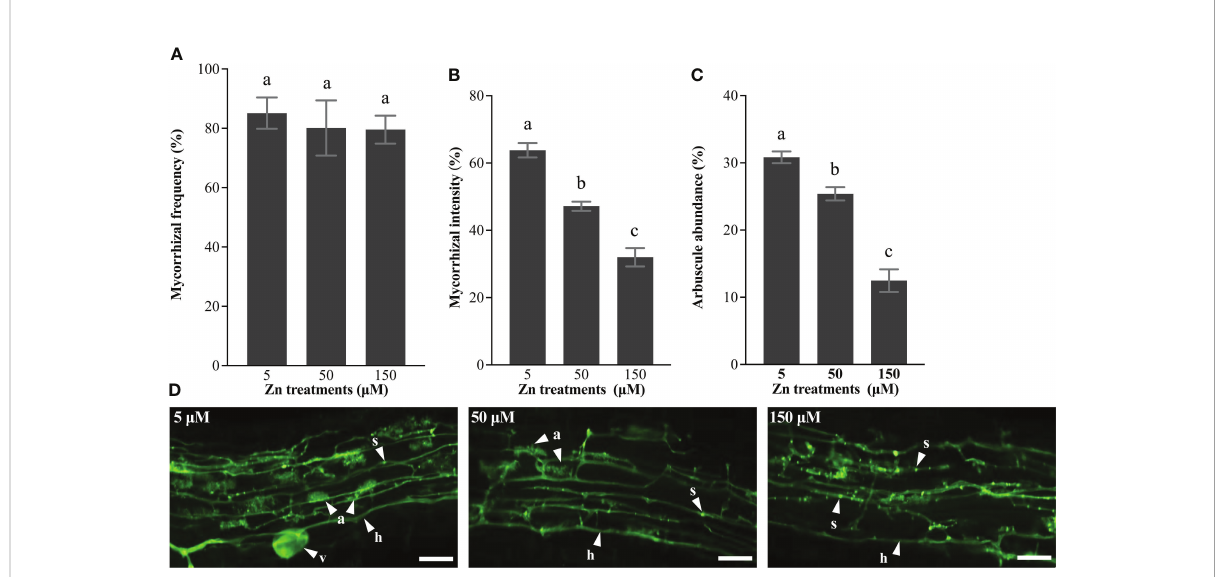
FIGURE 6 Mycorrhizal colonization. (A) Mycorrhizal frequency, (B) mycorrhizal intensity, and (C) arbuscule abundance were quanti fi ed using the MYCOCALC program. Values were indicated as mean ± SE. Different letters on the histograms indicated that the means signi fi cant differences ( P < 0.05). (D) a, arbuscule; h, hyphae; v, vesicles; s, septa; bar, 50 m